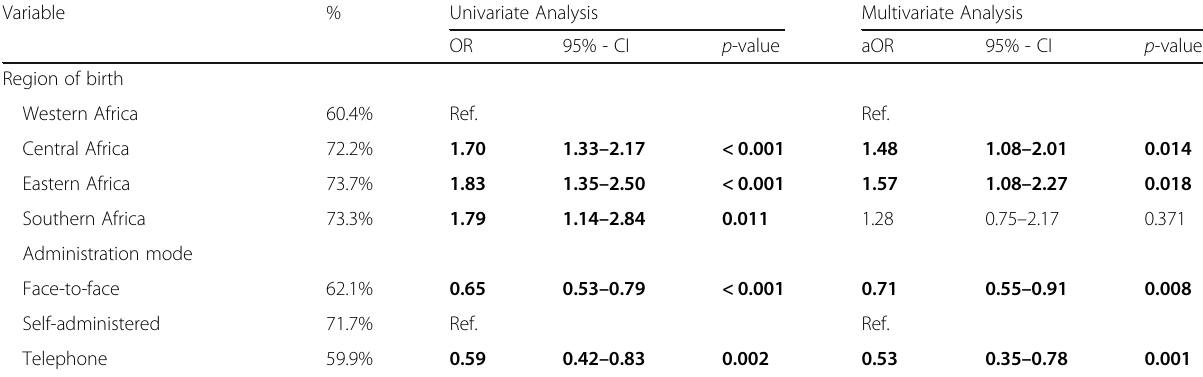
Table 7 Multivariate analysis on HIV test uptake (ever been tested = 1, not tested = 0), n = 1514 (Continued) Variable